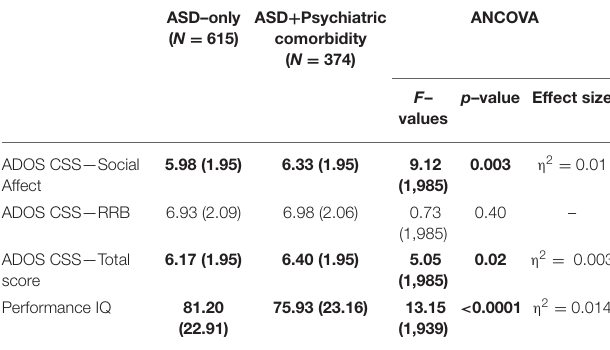
TABLE 2 | ANCOVA (controlling for gender and age) on ADOS and Performance IQ between ASD with or without Psychiatric Comorbidity. ASD–only ASD + Psychiatric ( N = 615)